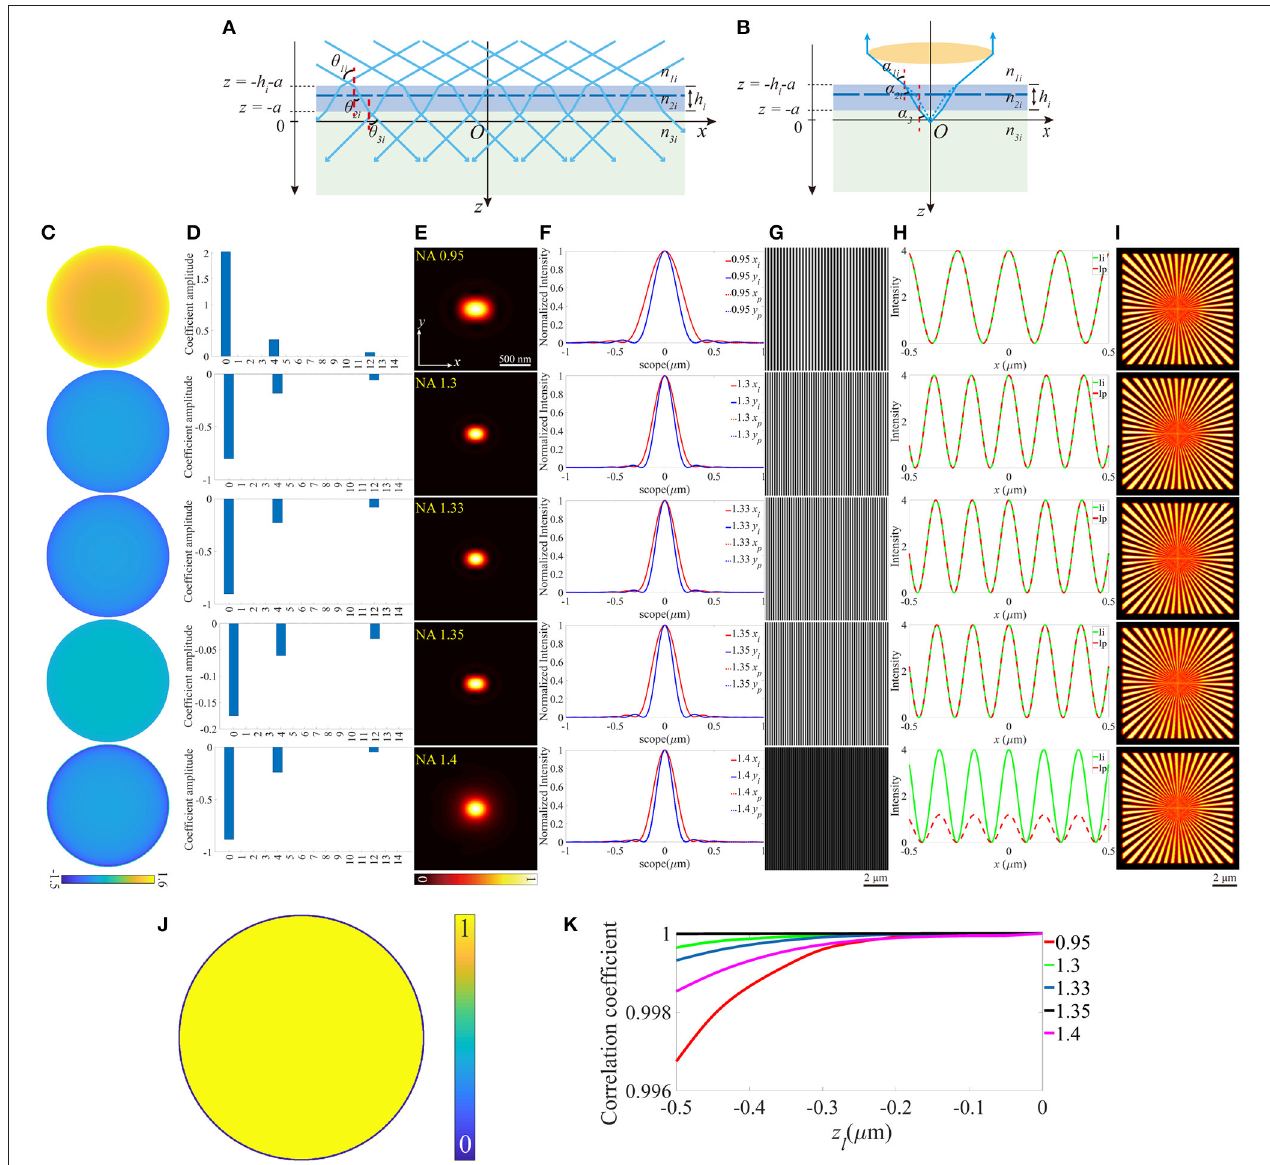
FIGURE 3 | The aberrations induced by the increase of the focal depth. (A,B) The case that objective focuses deeper into the sample medium. (C) The pupil functions calculated from the case depicted in (B) . (D) Zernike decomposition of the pupil functions shown in (C) . (E) The PSFs on the plane z = 0, calculated from the corresponding pupil functions. (F) The profiles of the ideal and biased PSFs in (E) . (G) The excitation patterns affected by biased z l . (H) The local profiles of the corresponding excitation patterns shown in (G) , the scope is − 0.5 ∼ 0.5 µ m. (I) The corresponding reconstructed images of SIM. (J) The effective pupil for NA = 1.4. (K) The correlation coefficients of SIM images with different z l